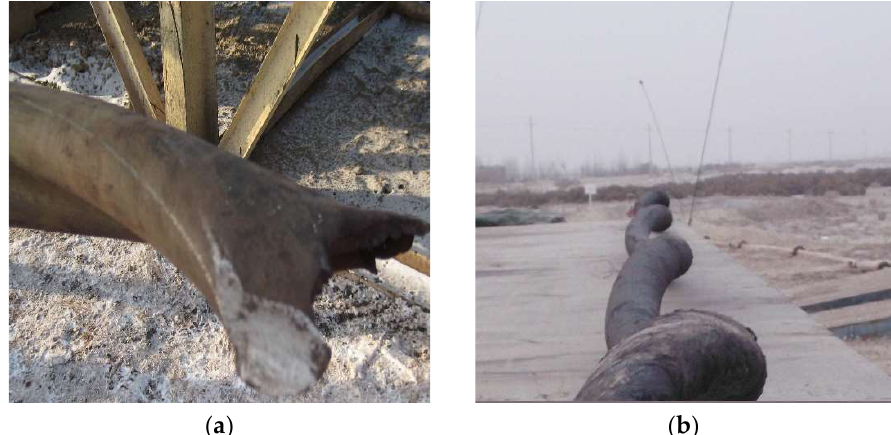
Figure 1. Tubing damage caused by perforating shock loads: ( a ) tubing breaking; ( b ) tube buckling.